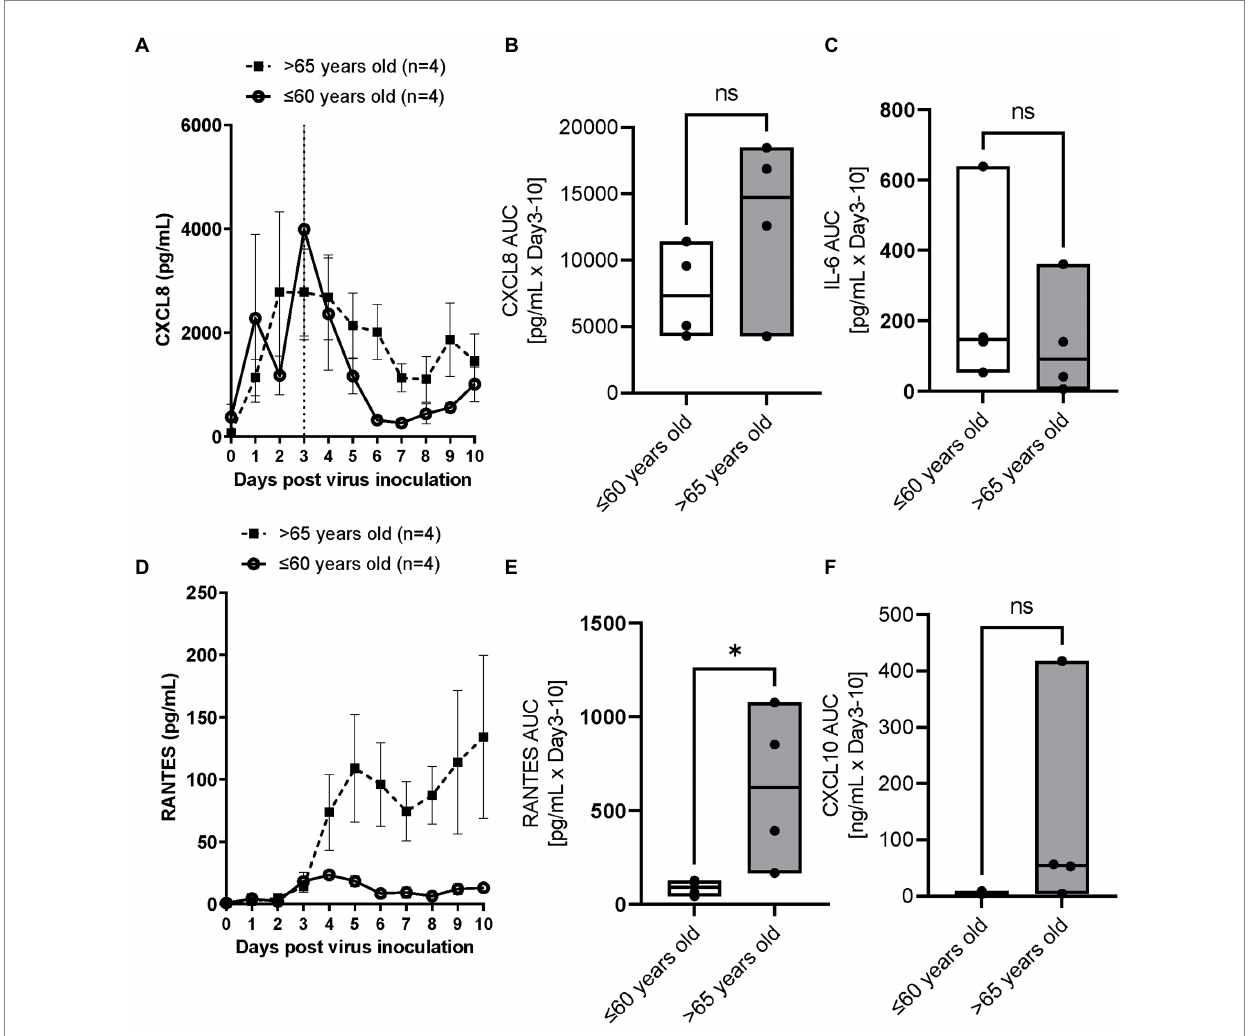
FIGURE 2 The comparison of RSV A2 induced cytokine biomarkers in apical washes collected from ALI-bronchial epithelium post RSV A2 inoculation in younger ( ≤ 60 years old) and elderly (>65 years old) groups. (A) Time-profile of CXCL8, (B) AUC (Day 3–10) of CXCL8, (C) AUC (Day 3–10) of IL-6, (D) Time- profile of RANTES, (E) AUC (Day 3–10) of RANTES, (F) AUC (Day 3–10) of CXCL10, mean ± SEM or min-max with median * p < 0.05. NS: not